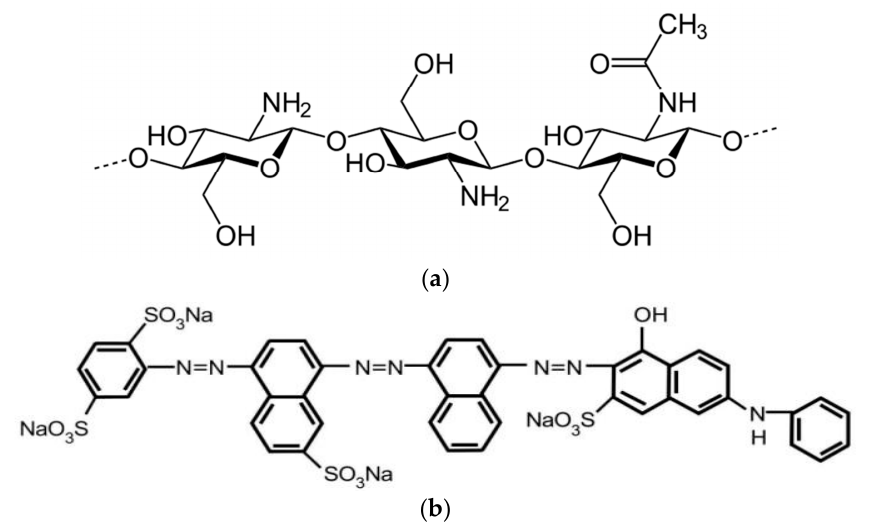
Figure 1. The chemical structure of ( a ) chitosan and ( b ) DB78